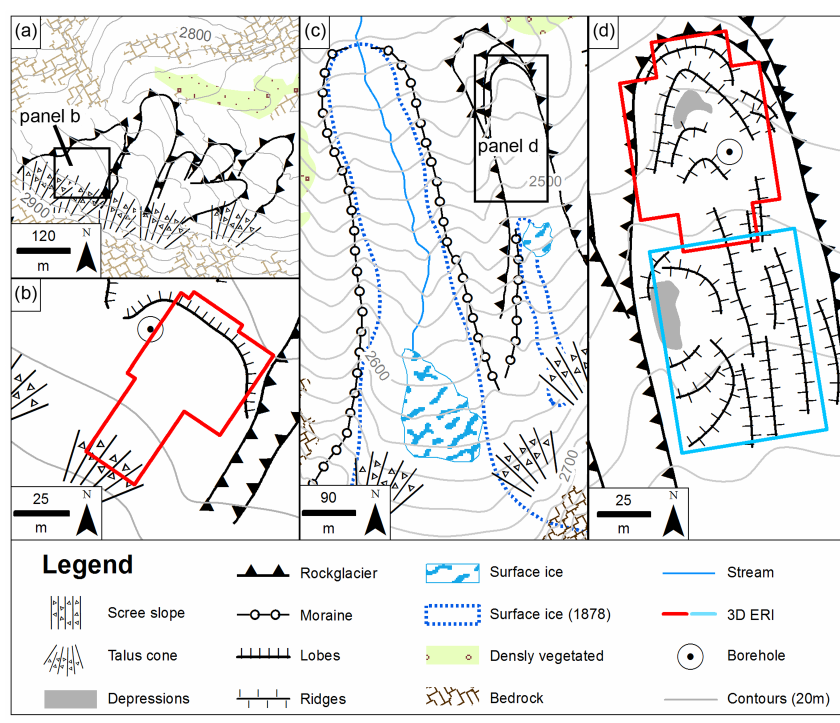
Figure 2. Geomorphological setting: (a, b) Nair and (c, d) Uertsch. Legend adapted from Kneisel et al. (1998). Table 1. Details on quasi-3-D ERI surveys. NAIR UERTSCH_01